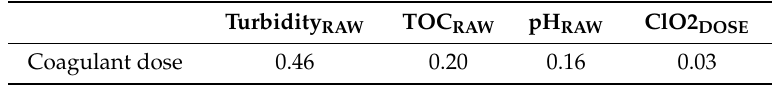
Table 2. Pearson’s correlations between influent raw water characterization and coagulant dose at the Montfull à DWTP (1 January 2014–31 December